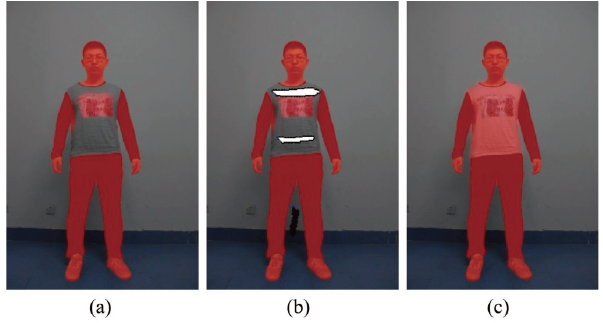
Fig. 11 User interface: (a) initial segmentation failure, (b) user adjustment, and (c) refined result. that our detector cannot segment it from the